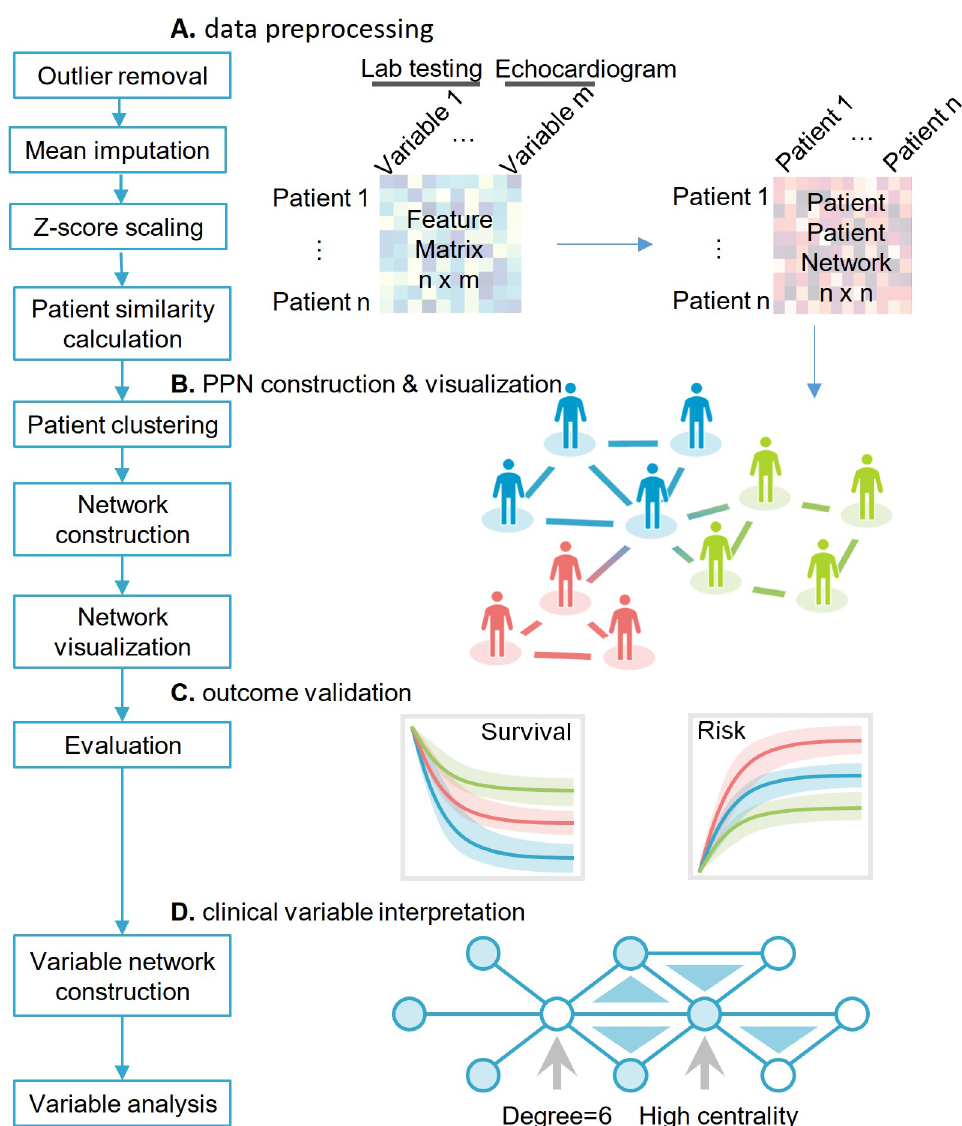
Fig 1. Overall study design. The overall study design included 4 steps: (A) data preprocessing; (B) PPN construction and visualization; (C) clinical validation using cardiac outcomes and survival analysis; and (D) clinical variable interpretation. The data preprocessing includes outlier removal, feature scaling by z-score method, and missing data imputation. With the preprocessed patient-clinical variable matrix, we used cosine measure as the similarity metrics for generating a patient–patient similarity network. Then, we performed K-means clustering to layout patients to different subgroups based on the cosine measure (see Methods). Patients with similar clinical characteristics are grouped in the same cluster and are visualized through a specific subgroup to form the final PPN. After the patient network construction and visualization, we used 2 clinical outcomes, mortality and CTRCD to evaluate performance of network- based clustering. Finally, we performed the clinical variable network analysis to enhance clinical interpretation of each risk subgroups with CTRCD. CTRCD AU : AbbreviationlistshavebeencompiledforthoseusedinFigs 1 (cid:0) 6 : Pleaseverifythatallentriesarecorrect : , cancer therapy–related cardiac dysfunction; PPN, patient–patient network.